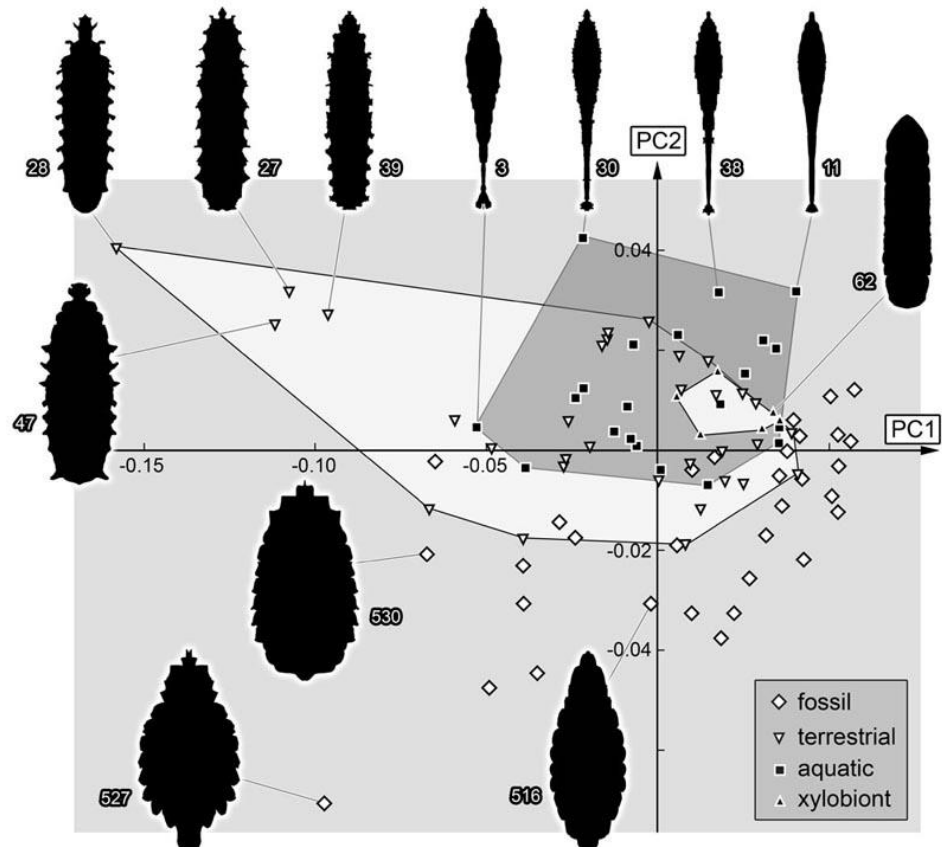
Figure 29. Morphospace comparing body shapes of modern and fossil stratiomyomorphan larvae. Modern larvae are marked based on their ecologies. Slightly different from the earlier study, the areas of aquatic and wood-associated larvae overlap strongly. This result fits with the idea of an evolutionary connection be- tween the two (see discussion in [13]). A stronger difference from the earlier study is that in the new analysis many or, in fact, most fossil larvae plot outside the area occupied by modern-day larvae. In the earlier study, the fossil larvae plotted well within the area of the modern forms. The enlarged data set used here likely polarised the analysis differ- ently, providing a different result. This new pattern makes it more difficult to use this comparison to infer the life habits of the fossils. Yet, it indicates that certain larval mor- phologies have been lost, possibly meaning that also specific ecological functions have been lost (see discussions in [32,33]). We must accept that morphotypes 2 and 7 especially differ quite strongly from their modern relatives, possibly representing early offshoots of the lineage toward modern rep- resentatives of Stratiomyidae. Hence, we have no good basis for estimating their ecology. For morphotype 1, the situation is slightly better. First, these largely plot closer to the